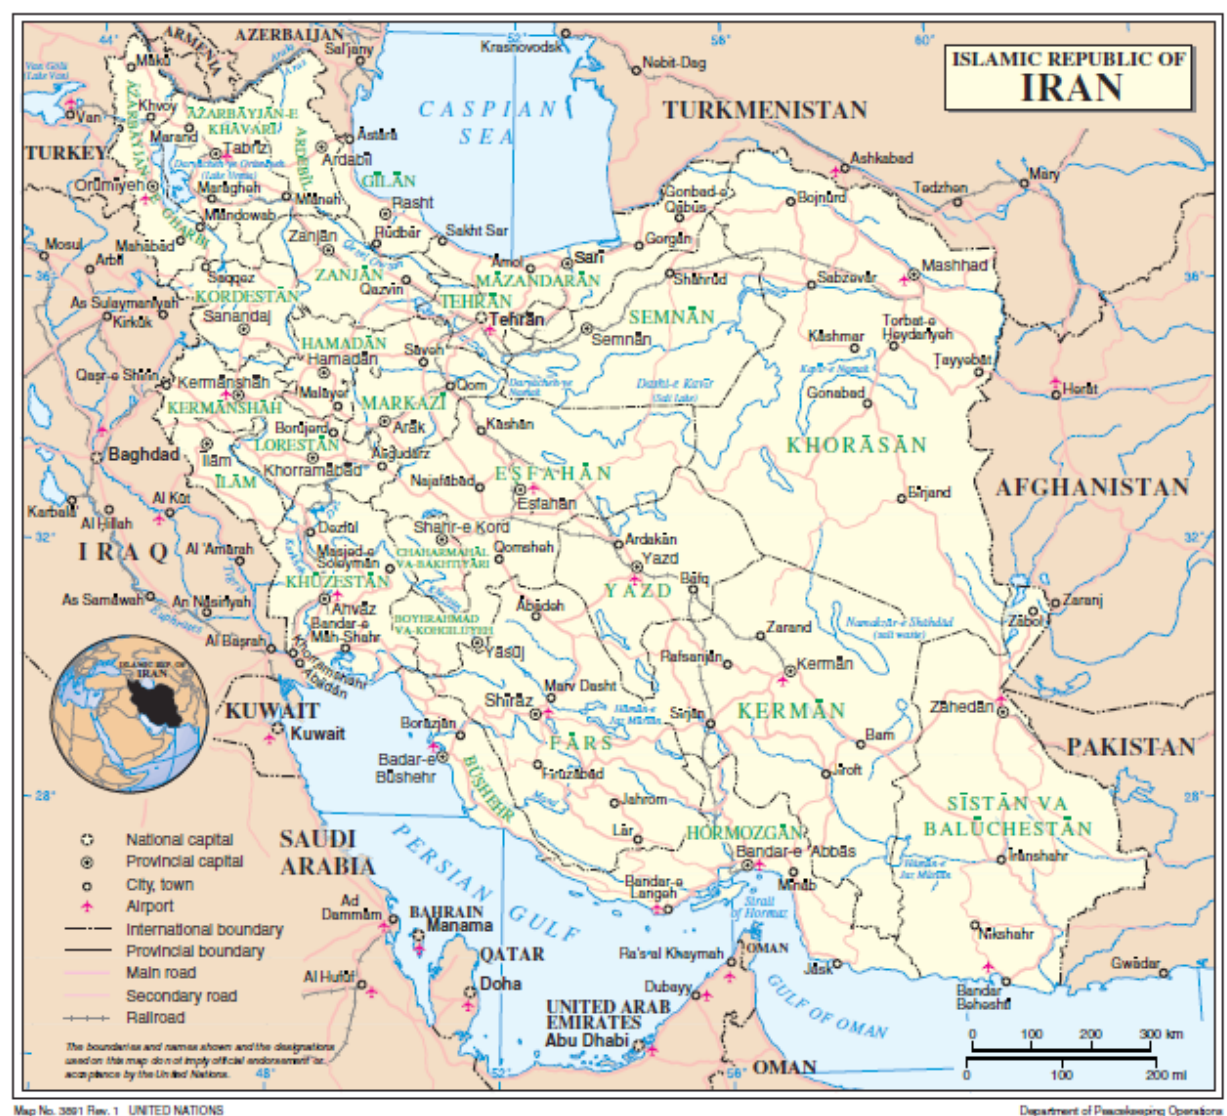
Figure 1. Modern Iran